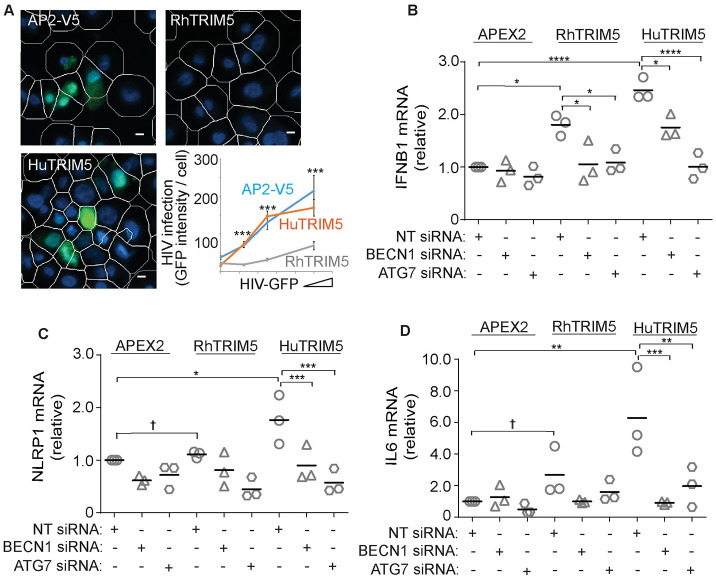
Autophagy factors are required for TRIM5-driven inflammatory gene expression in macrophages.(A) Differentiated THP-1 cell lines stably expressing APEX2-V5 alone or APEX2-V5 tagged TRIM5 (human or rhesus) were infected with HIV-GFP and the percentage of infected (GFP-positive) cells was determined by high content imaging. White mask, automatically identified cell boundaries. Scale bar, 50 μm. Plot, the mean above-background GFP intensity per cell (a measure of transduction efficiency) following infection of increasing amounts of HIV-GFP. N = 5 independent biological replicates, >500 cells analyzed per replicate. (B-D) Quantitative PCR analysis of THP-1 macrophage cells stably transduced with lentiviruses expressing rhesus or human TRIM5 fused to APEX2 or APEX2 alone and subjected to the indicated siRNA-mediated knockdowns. The abundance of IFNB1 (B), NLRP1 (C), and IL6 (D) were determined relative to the abundance of 18S ribosomal RNA. Quantitative PCR analysis of knockdown efficiency is shown in S2C and S2D Fig. Data, each data point represents an independent biological replicate; *, P < 0.05; **, P < 0.01; ***, P < 0.001, ****, P < 0.0001; †, not significant by ANOVA.